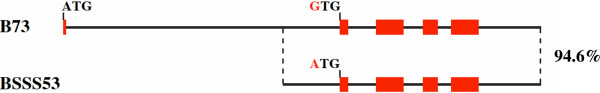
Alignment of the ZmCDA1 and ZmCDA3 genes. The coding sequences of the ZmCDA1 and ZmCDA3 genes from B73 and BSSS53 are depicted graphically as bars to illustrate their common sequences. The start codons are highlighted. Exons are shown in red block, nucleotide change from G to A is shown in red letters.